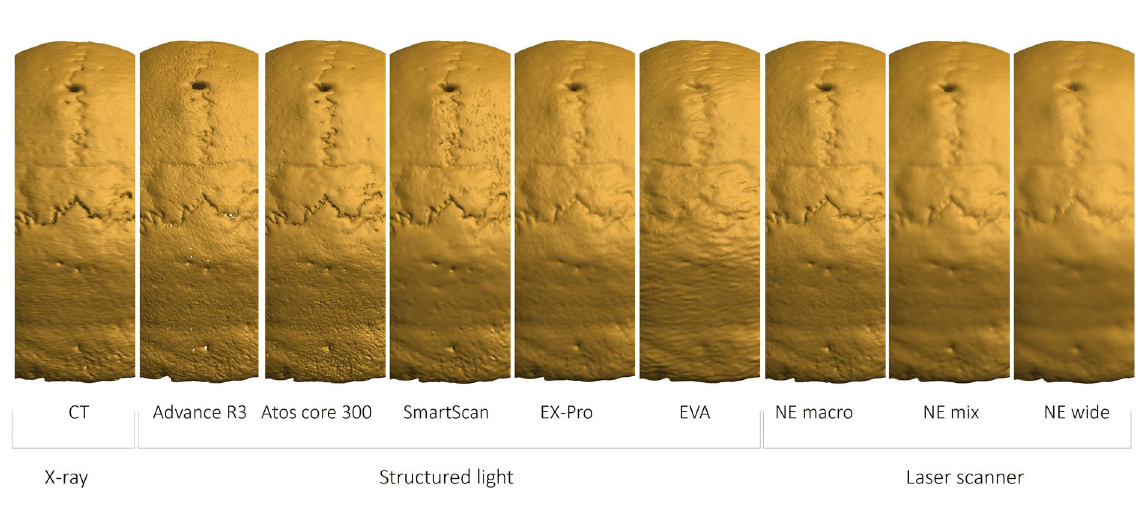
Fig. 6.3. Back view of the skull digitised with different scanners.